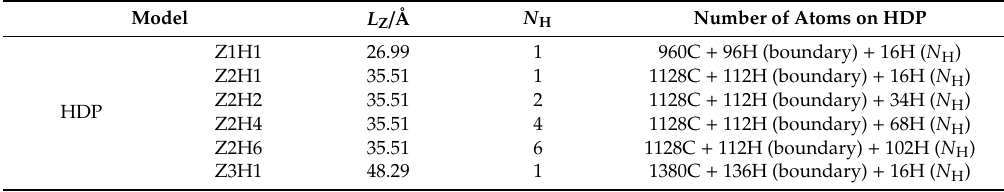
Table 1. Initial parameters of the HDPs in the nanoconvertor in Figure 11.